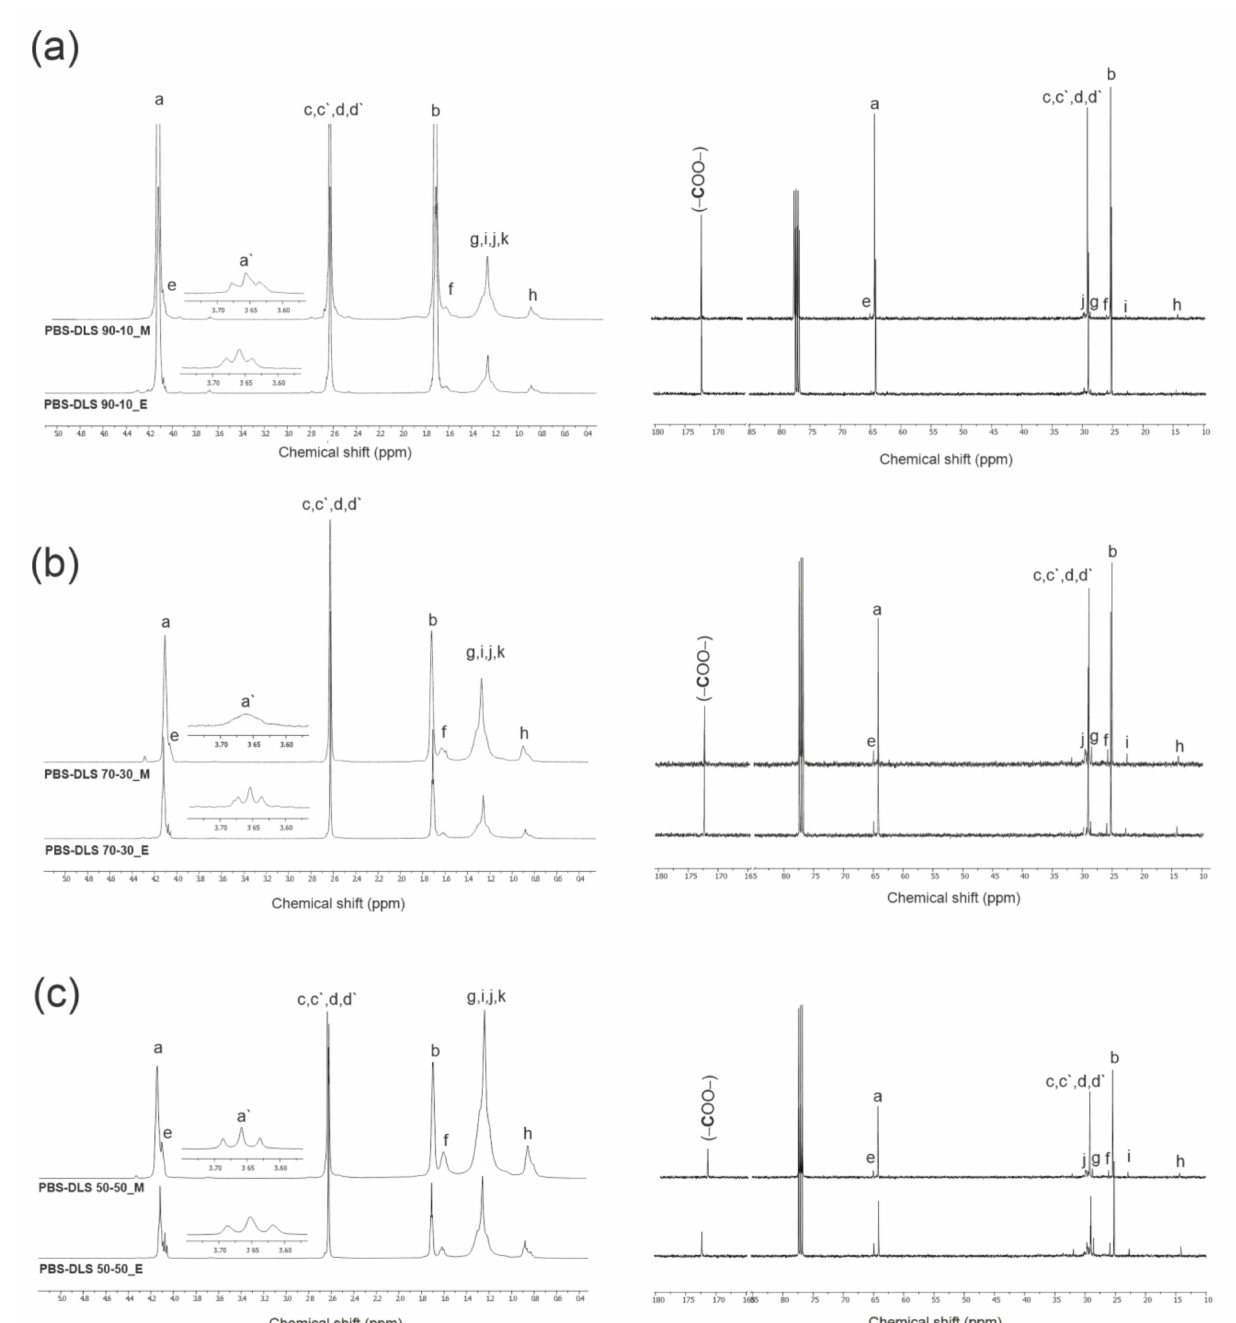
Figure 3. 1 H- and 13 C NMR spectra of PBS-DLS copolymer series containing ( a ) 90 wt% ( b ) 70 wt% with permission from [18] Wiley, Copyright © 2020 Sokołowska M. et al. ( c ) 50 wt% of hard PBS